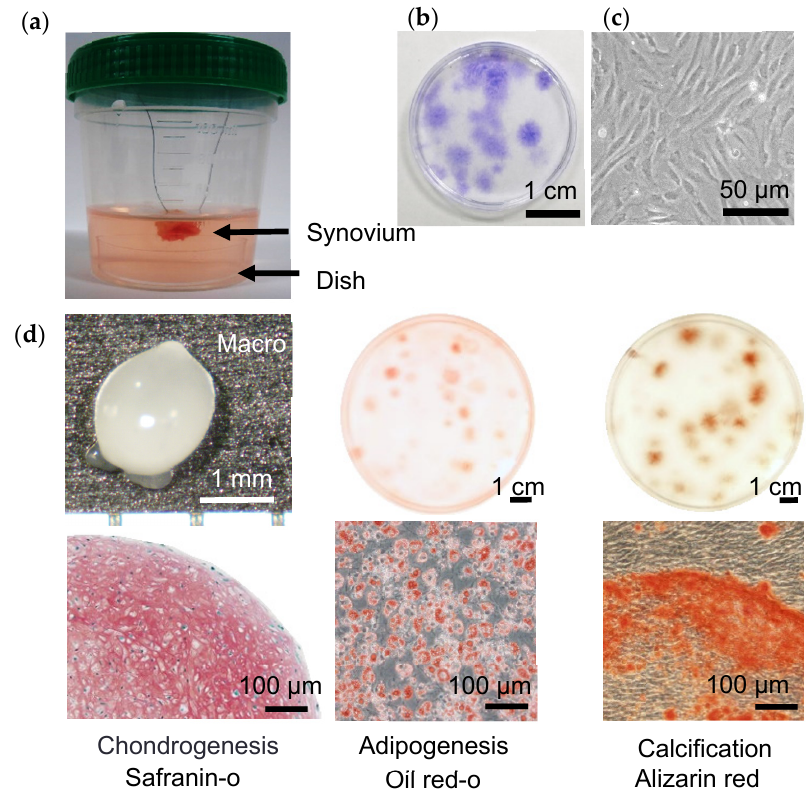
Figure 4. MSCs released from suspended synovium. ( a ) Suspended synovium culture model. Approximately 1 g of synovium was suspended in a bottle containing a culture dish at the bottom. ( b ) Cell morphology. After culturing for 7 days, the dish was observed. ( c ) Culture dishes stained with crystal violet. ( d ) Chondrogenesis, adipogenesis, and calcification (reproduced from [11]).